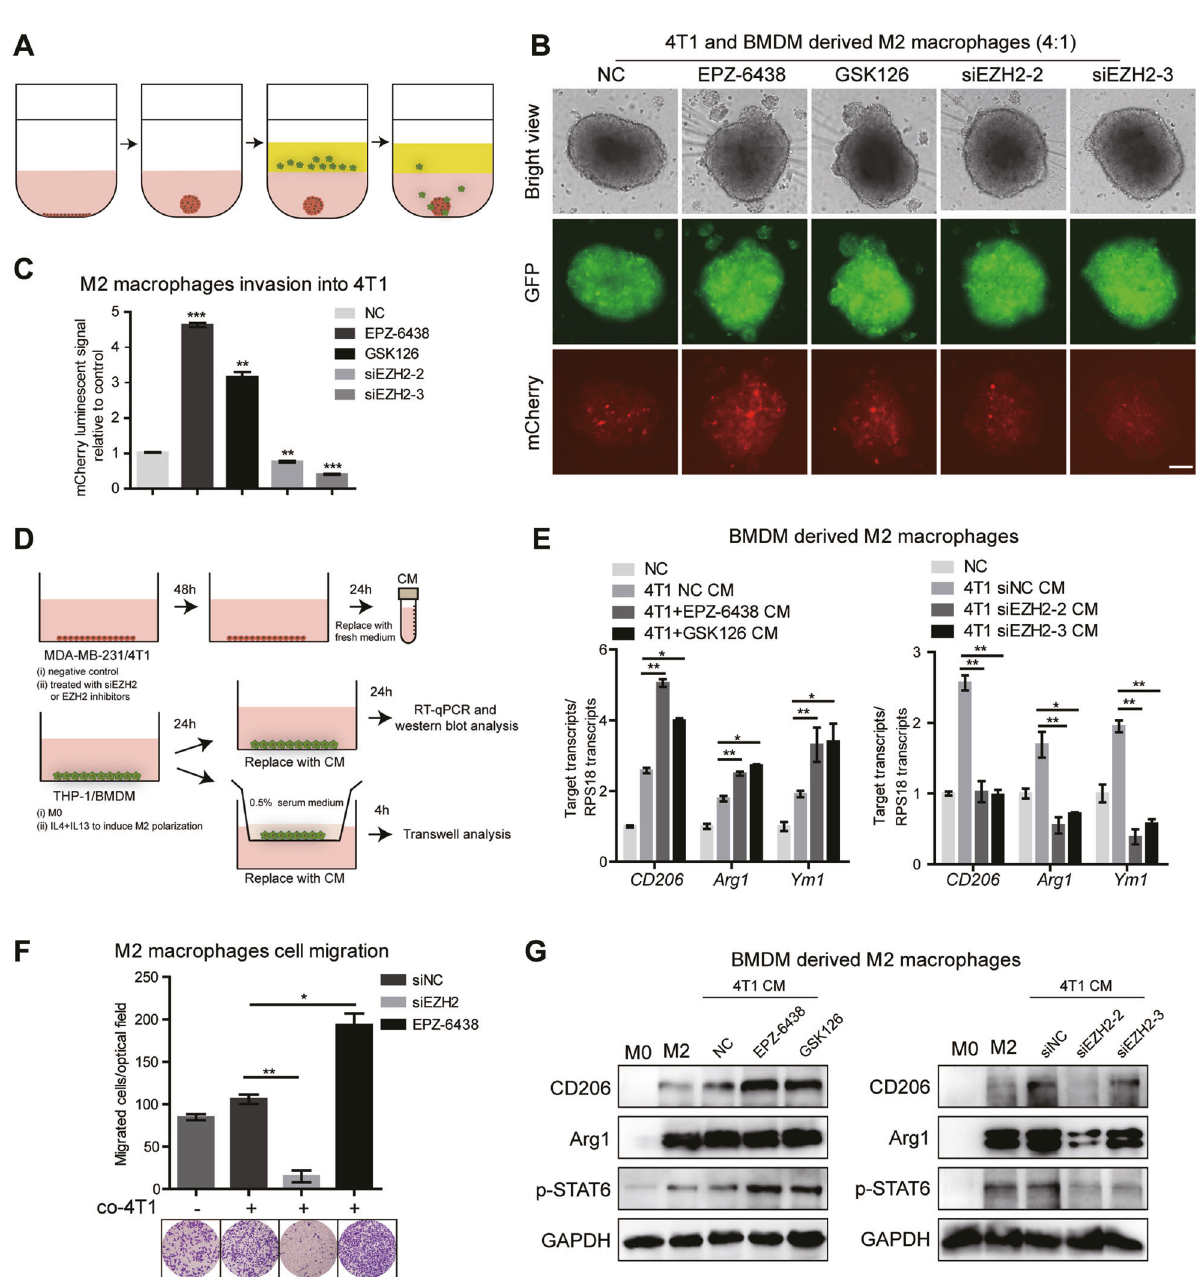
Fig. 2 EZH2 inhibitor-treated BC cells activate TAMs to a M2 phenotype. A Scheme of the work fl ow. 4T1 cells labeled with GFP, a green tracking dye were transiently transfected with siEZH2 or treated with EPZ-6438, and seeded in a 3D culture quali fi ed 96 well spheroid formation plate for spheroid formation. After 3-6 days, spheroids were formed and 100 µl of invasion matrix containing BMDM cells polarized by IL-4 and IL-13 treatment and labeled with mCherry, a red tracking dye were added. The cell number ratio of 4T1 and BMDM was close to 4:1. Representative photographs of in fi ltrating macrophages into the 4T1 microsphere (magni fi cation, ×20) were shown B and relative mCherry luminescence signals were quanti fi ed C . Scale bar represents 100 μ m. D Scheme of the work fl ow. BC cells were transiently transfected with siEZH2 or treated with EPZ-6438. CM was used as a chemoattractant for macrophages in a transwell migration assay. E The relative transcript levels of the M2-related genes in the CM-treated BMDM were determined by RT-qPCR. F The migration rates of BMDM- derived M2 macrophages with or without the co-culture of 4T1 CM were determined by transwell assay. G The expression of M2 macrophage markers in co-cultured BMDMs were tested by western blot. The graphs were shown as means ± SD, n = 3 independent experiments; * p < 0.05; ** p < 0.01; *** p < 0.001, compared with control, p values were obtained using a two-tailed Student ’ s t test. polarizing toward M2 macrophages, though the induction was not 4T1 siEZH2 CM compared with siNC CM (Fig. S2D). Since tumor very strong, which indicated that the driving force of M2 cells and macrophages share a common TME, it ’ s very likely that macrophage induction came from the interaction with tumor the drugs we use to treat tumor cells also target macrophages in cells. Overall, these observations suggested that the crosstalk the microenvironment. Thus we tested the direct effect of EZH2 between TAMs and EZH2 inhibitor-treated BC cells induces inhibitors on macrophage polarization. As shown in Fig. S2E, F, differentiation of macrophages towards a M2-type state. EPZ-6438 and GSK126 alone could facilitate M0 macrophage Cell Death and Disease (2022)